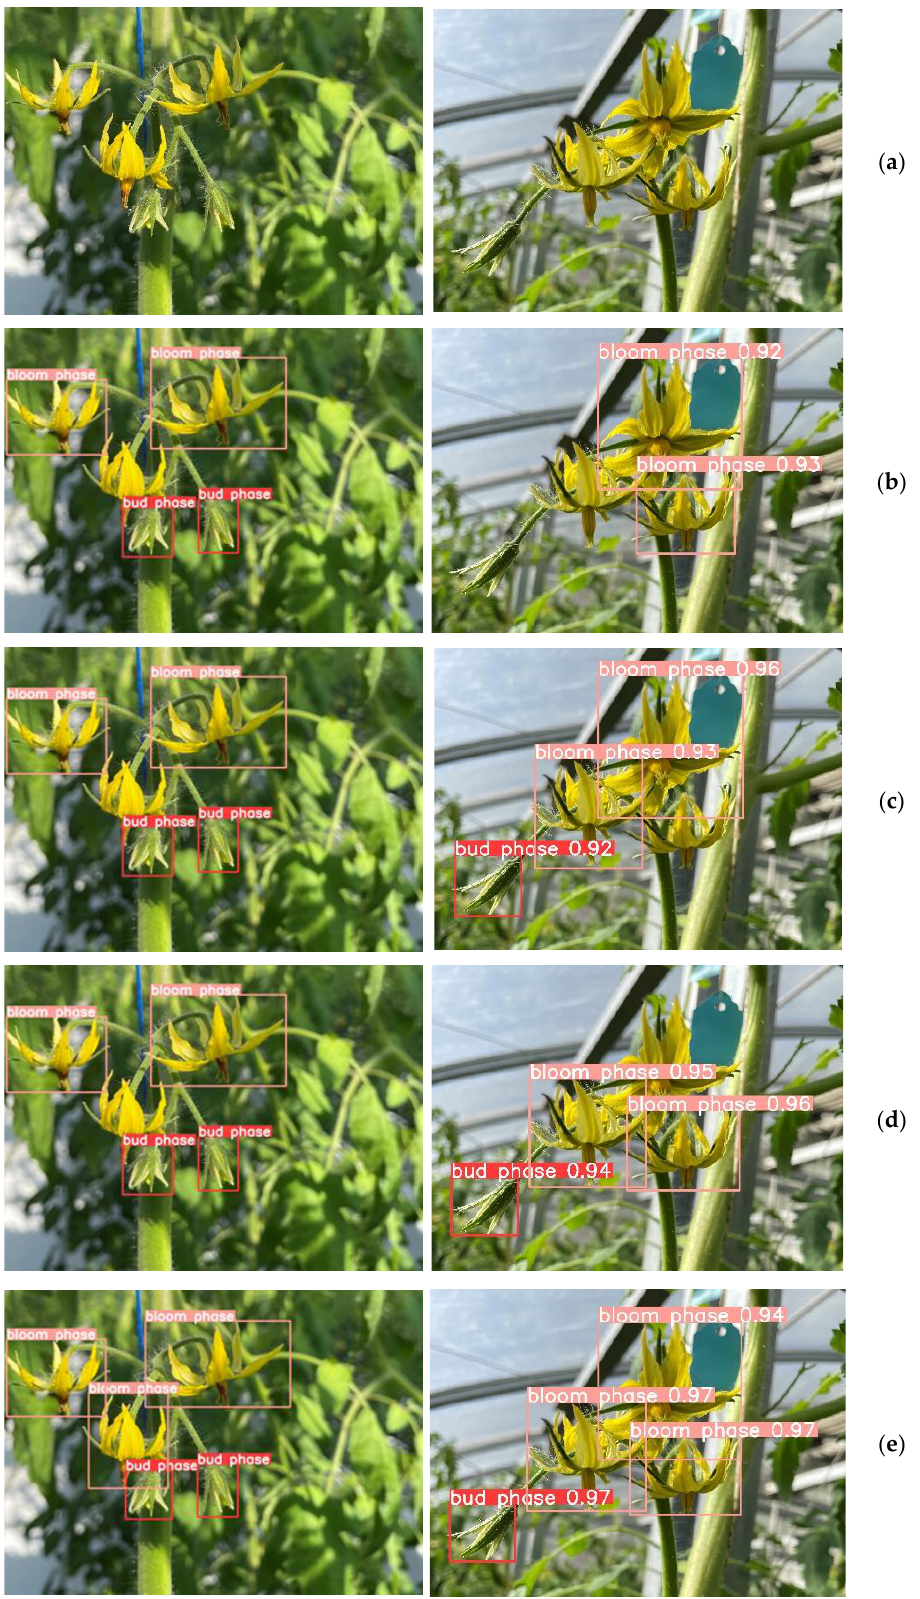
Figure 10. Recognition results of the comparison between models for different phases: ( a ) original images; ( b ) Yolov5s; ( c ) Yolov5s + fusion layer; ( d ) Yolov5s + CBAM; and ( e ) FlowerYolov5.